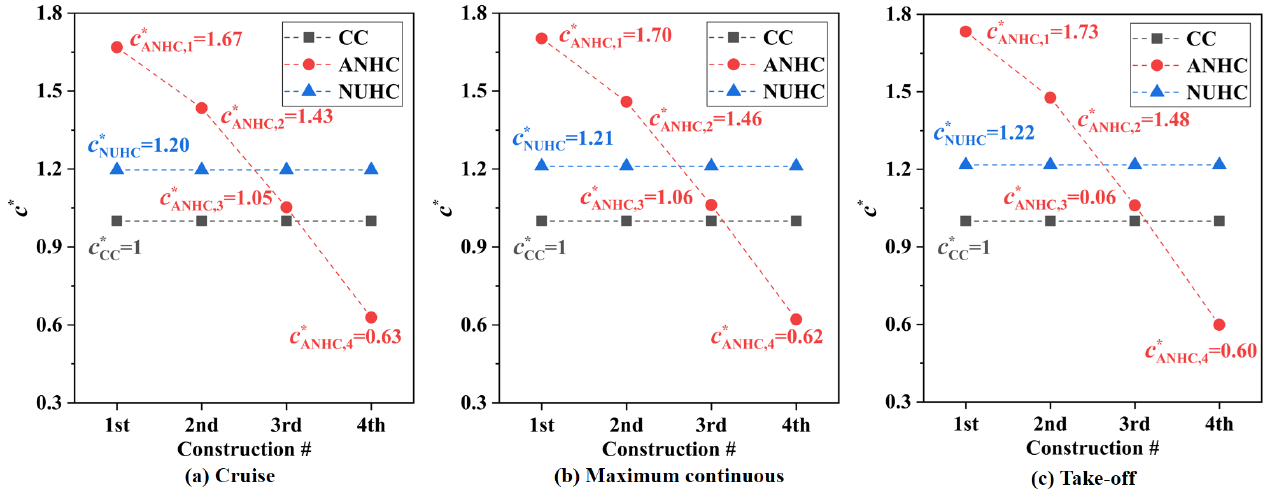
Figure 21. Labyrinth clearance profiles.